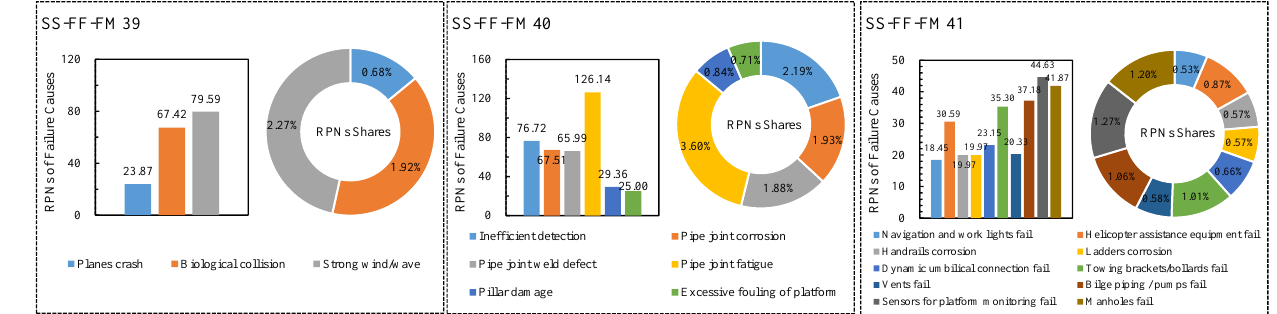
Figure 7. Features of failures of the floating foundation/SS-FF-FM39: Hit by dropped objects; SS-FF- FM40: Watertight fault; SS-FF-FM41: Additional structures fail.